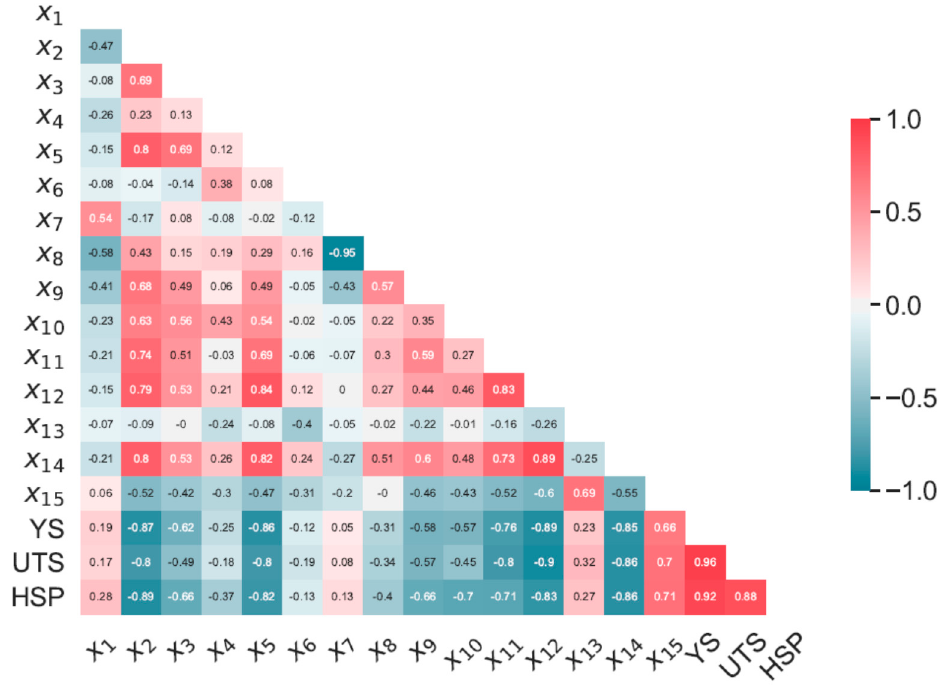
Figure 5. R-value calculated between the thermal desorption spectroscopy (TDS) curve-fitting parameters of the studied steels measured experimentally including yield stress (YS), ultimate tensile strength (UTS), and hydrogen sensitivity parameter (HSP) data.